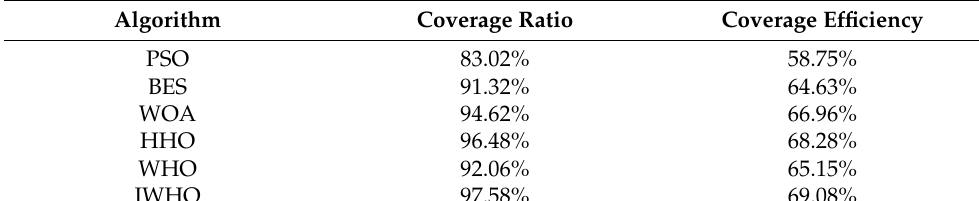
Table 9. Comparison of experimental results from various algorithms.